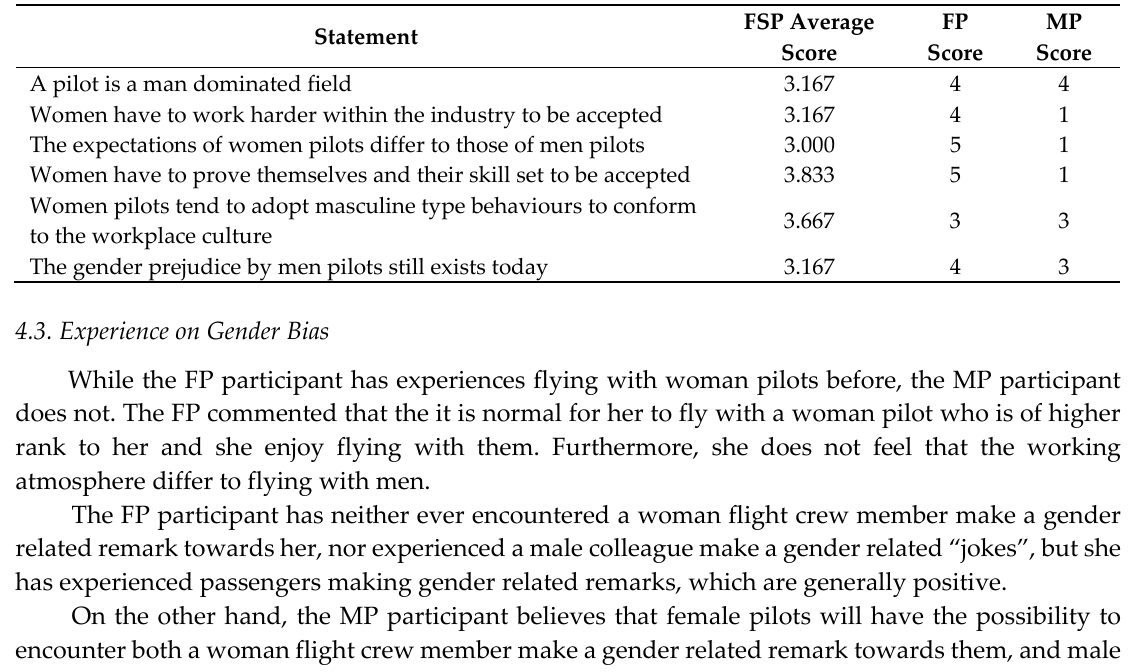
Table 3. Perspective on Gender